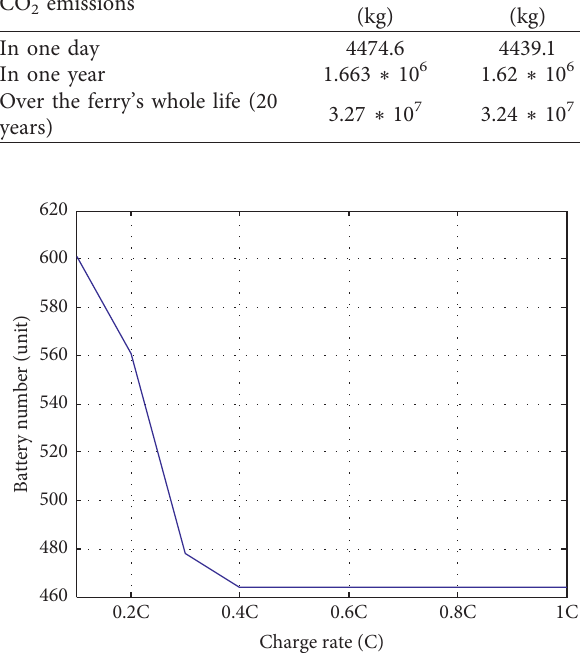
Figure 8: Relationship between the battery number and charge rate.